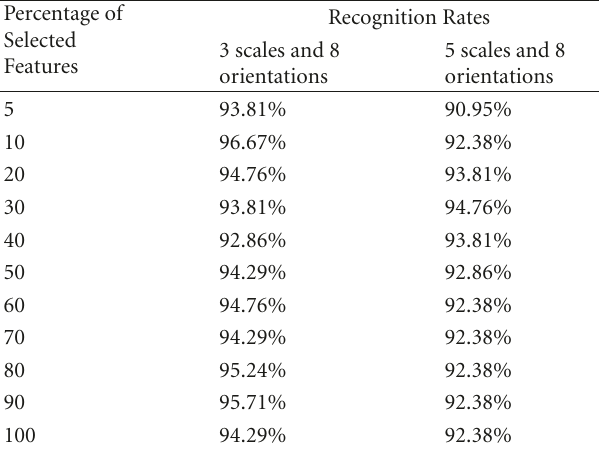
Table 1: Recognition rates for di ff erent levels of the e ff ective Gabor features.